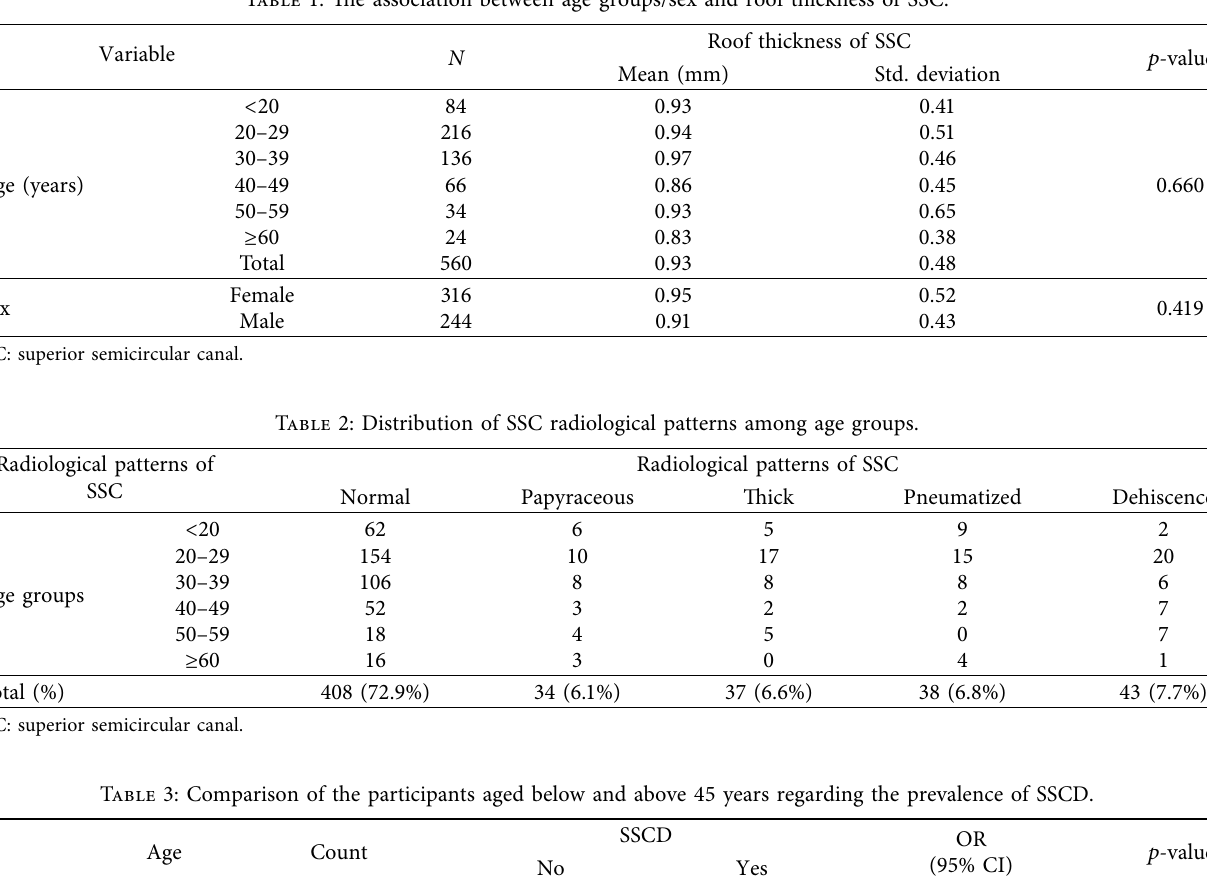
Table 1: Te association between age groups/sex and roof thickness of SSC.